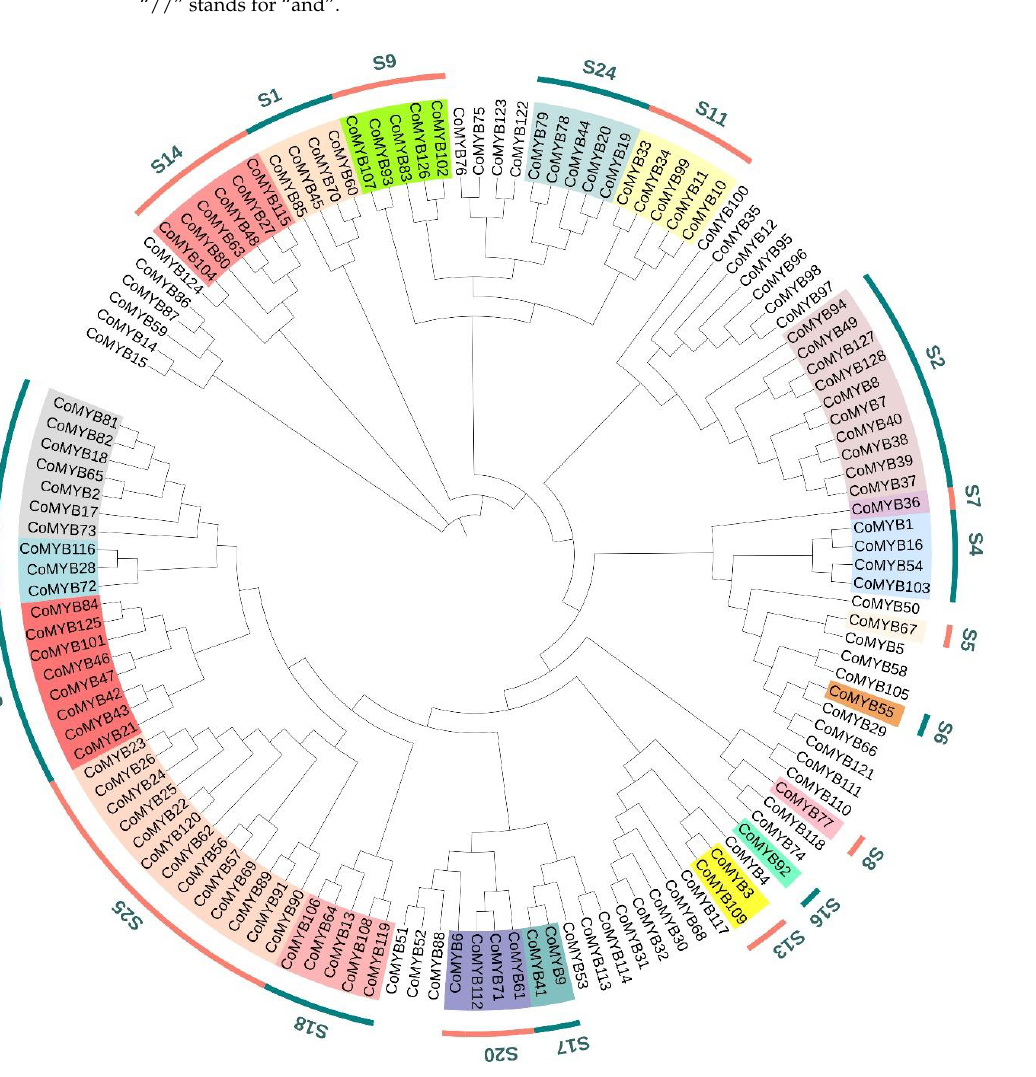
Figure 5. Phylogenetic tree of 128 R2R3-MYB transcription factors of C. oleifera . Different colored background colors and strips represent different subgroups. The text of the outermost wheel represents the names of the different subgroups.